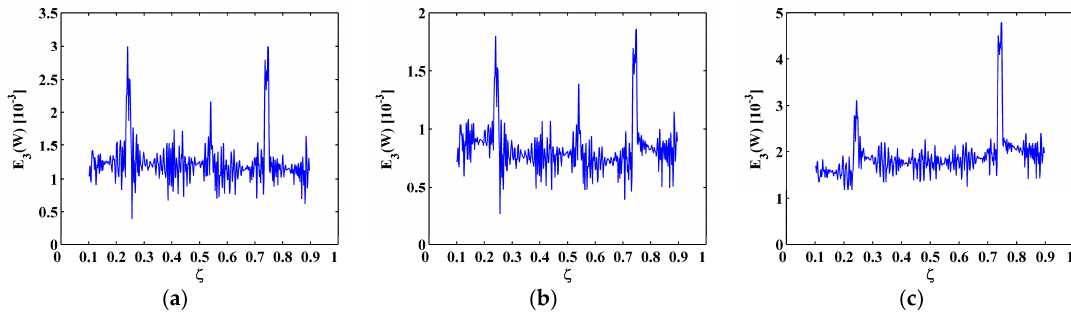
Figure 9. MRM-TKE for the ( a ) sixth; ( b ) seventh; and ( c ) eighth mode shapes with 50 dB SNR. Materials 2017 , 10 , 656